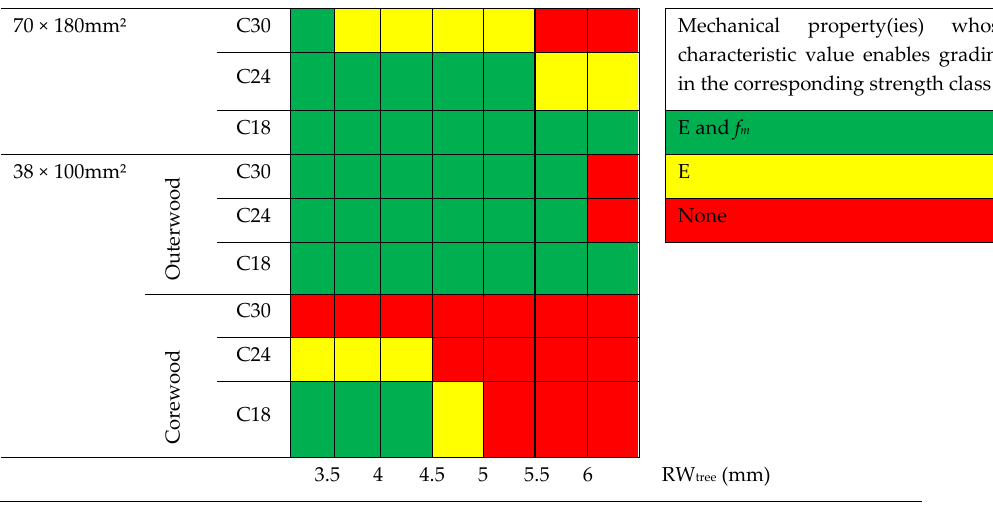
Figure 2—namely that, for the 21 combinations studied (three types of boards × seven RW tree classes), f m,k was always more limiting than E mean (remembering that, in practice, density never impedes accessing the highest mechanical class). It should however be noted that E is often more important than f m in the dimensioning of structures: The cross sections imposed by the project managers are indeed calculated above all to maintain the deformations of the structure below a given level, which is obviously much lower than that required to break the components of this structure. Table 5 is only valid for the samples studied here and was drawn up on the basis of the “reasoned values” (i.e., taking into account the critical interpretation of the trends observed as carried out in Sections 3.3.1 Table 5. Structural use ability of the studied board batches according to the characteristic values of E and f m and of the growth rate of the trees from which the boards originate.